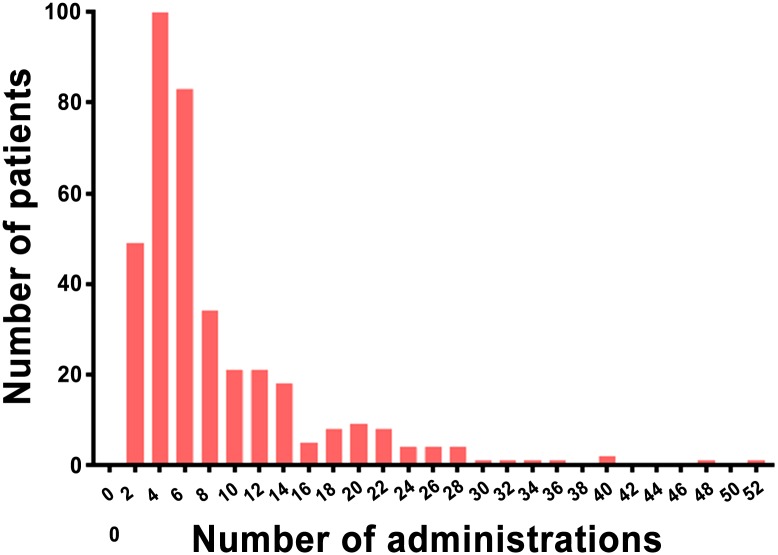
Histogram of the number of macrocyclic ionic MR contrast agent administrations in the study population.